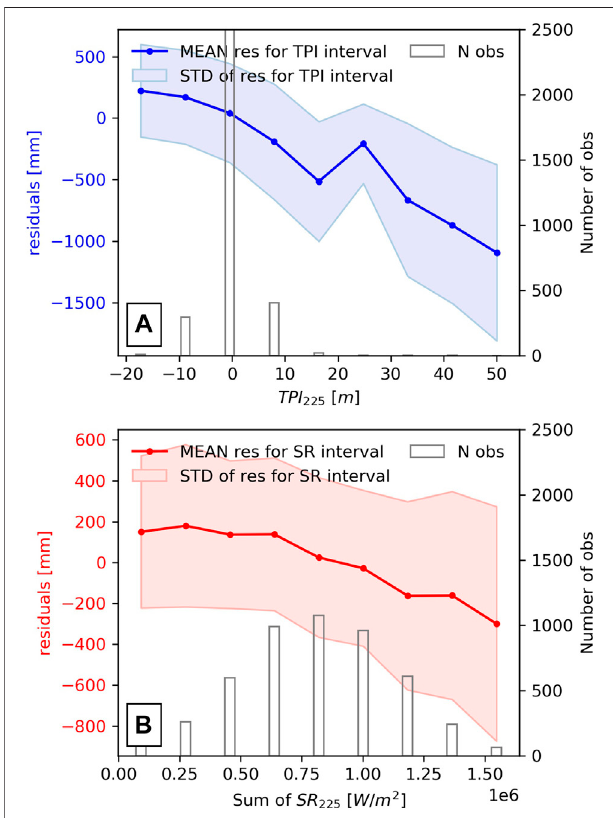
FIGURE5|(A) showstherelationshipbetweentheresiduals(SWE end-of- − SWE season 0.97 Step-1 ) and TPI 225 , while (B) describes the relationship between the residuals and sum of SR 225 for the entire winter seasons. All the measurementsofalltheglaciersandwinterseasonsareconsidered.The bars indicate the number of ground measurements related to the speci fi c interval of the TPI 225 (and the SR 225 )